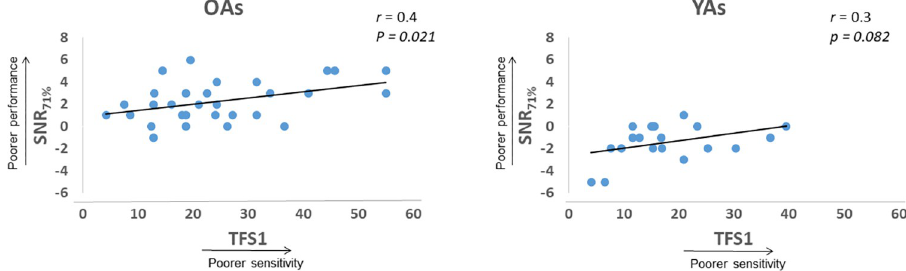
Fig 3. Scatter plots showing relationship between performance on the TFS1 task and the SNR 71% in older and younger participants.